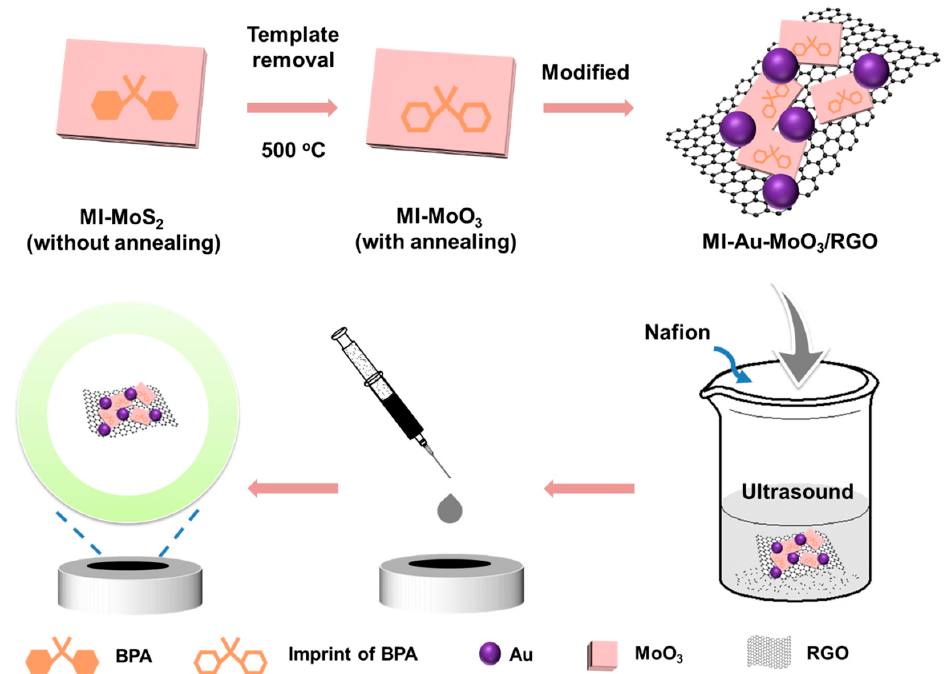
Scheme 1. The synthe t ic processes of MI-Au-MoO 3 / r GO